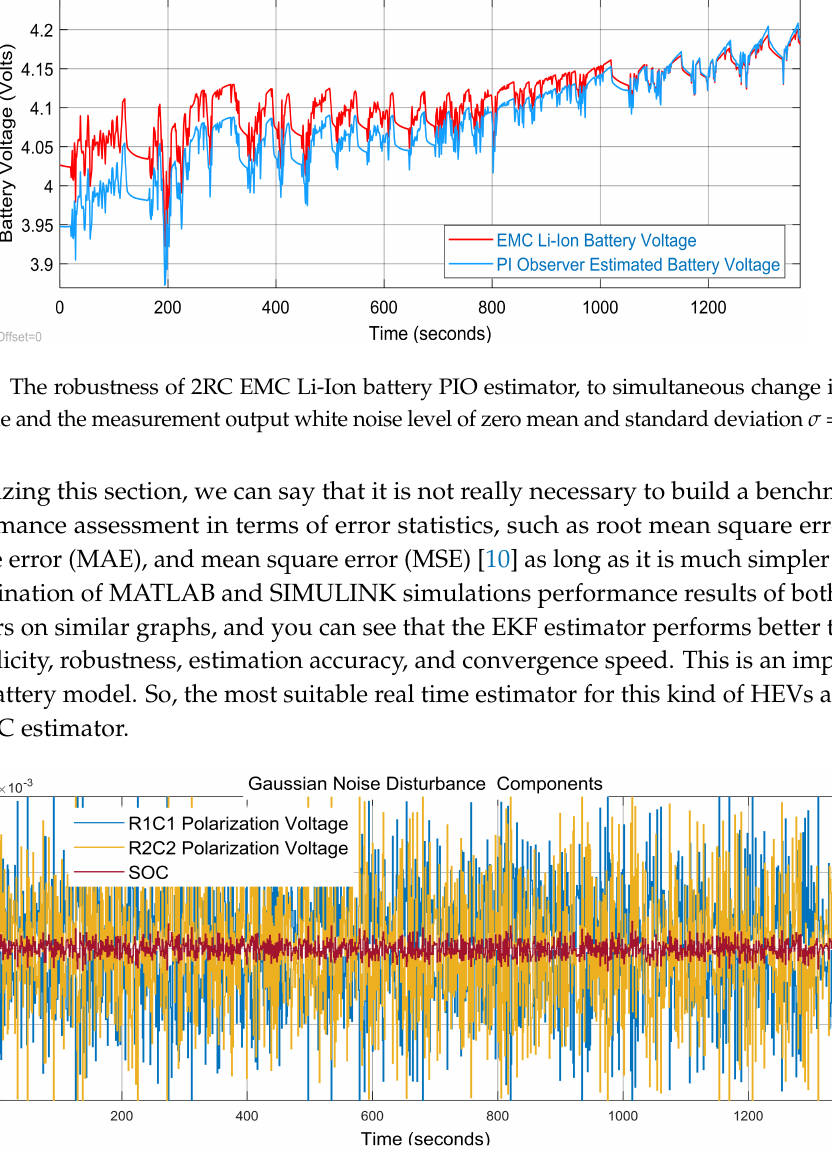
Figure 39. The measurement output white noise level of zero mean and standard deviation σ =